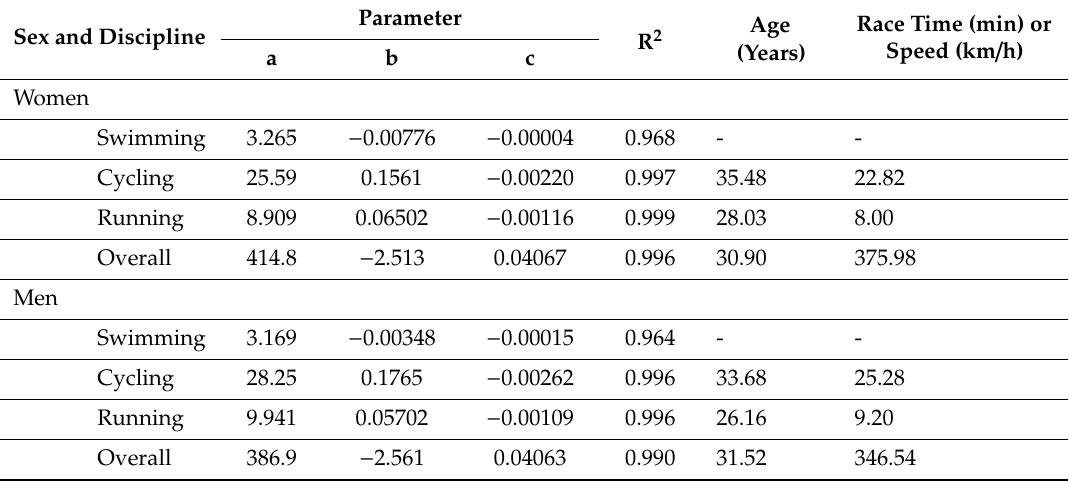
Table 1. Parameters in second-order polynomial regression Y = a + bx + cx 2 using the race time of all athletes in 1-year age intervals by